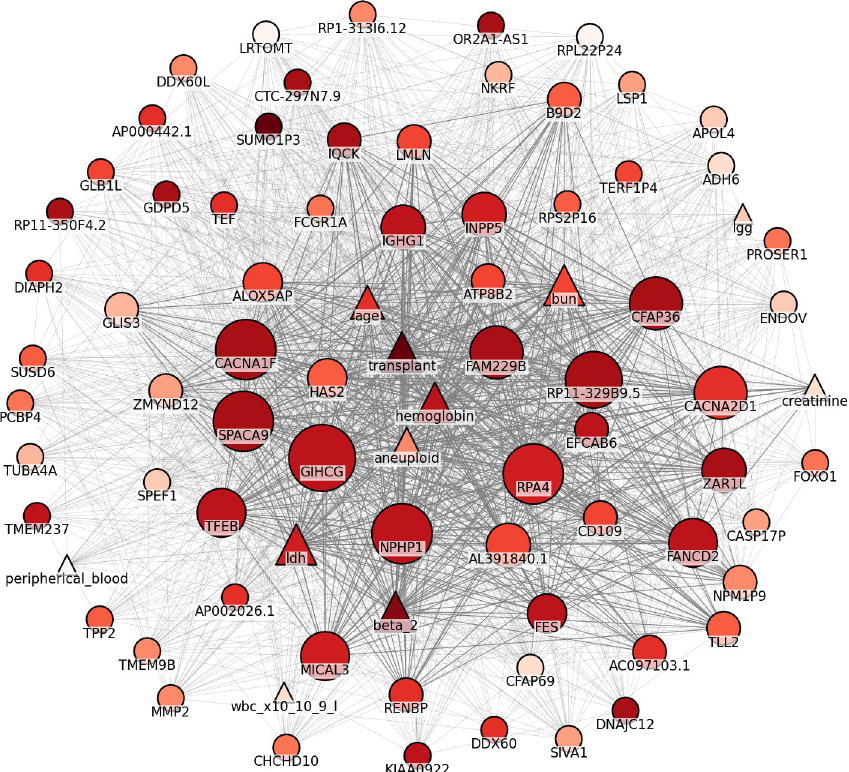
Fig 5. Relationship between clinical markers and genes represented as an undirected graph. Triangles and circles represent clinical markers and genes, respectively, while color intensity is inversely proportional to average p-value. The edge width corresponds to the number of CV rounds that the connected markers were selected together.